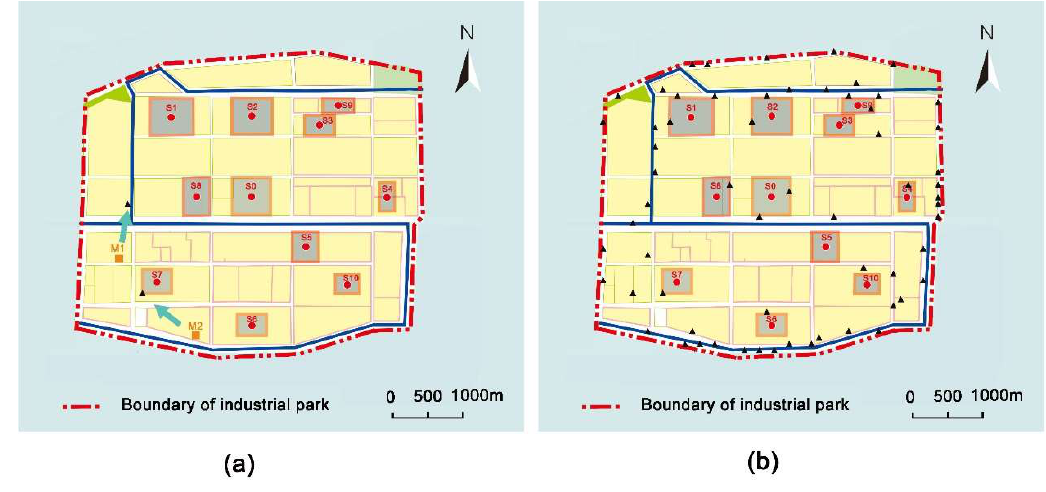
Figure 10. The spatial distribution of the optimal AQMN in Scenario III. Black triangles indicate added monitors in the optimal scheme. The numbers of monitors are ( a ) 2 and ( b ) 62.